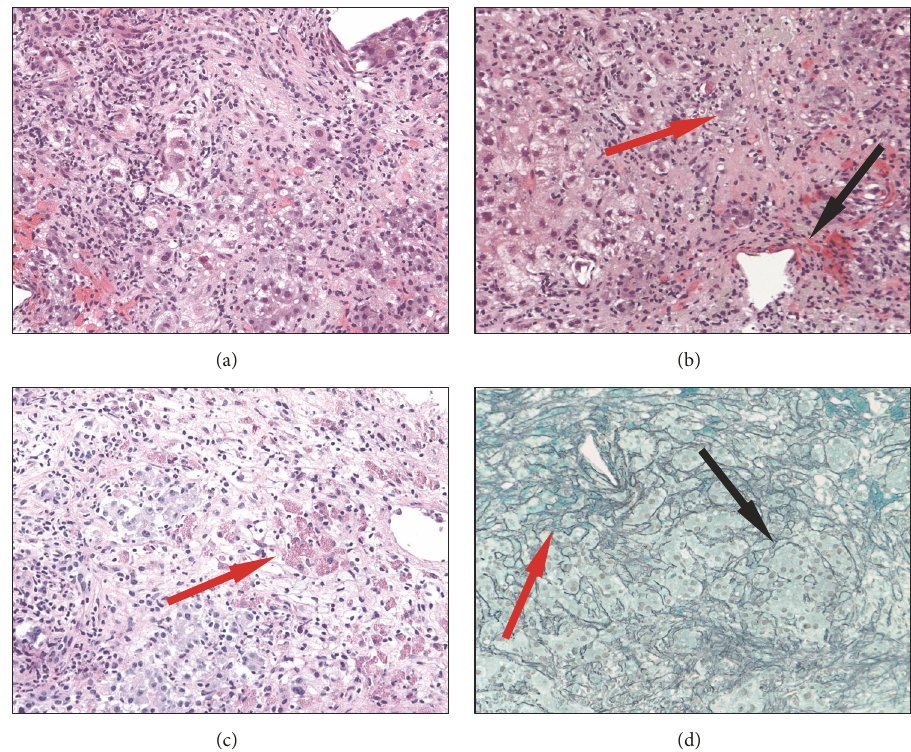
Figure 2: (a) H&E-stained histologic section of the liver biopsy demonstrating severe acute hepatitis characterized by a panlobular mixed inflammatory infiltrate with extensive hepatocyte necrosis (200x magnification). (b) H&E-stained histologic section of the liver biopsy demonstrating bridging parenchymal necrosis(red arrow) and cholestasis (blackarrow) (200x magnification).(c)Periodicacid-Schiffstained histologic section of the liver biopsy with diastase pretreatment highlighting numerousceroid pigment-laden macrophages (red arrow) (200x magnification). (d) Reticulin-stained histologic section of the liver biopsy demonstrating areas of parenchymal collapse (red arrow) and regenerative thickening of the hepatocyte plates (black arrow) (100x